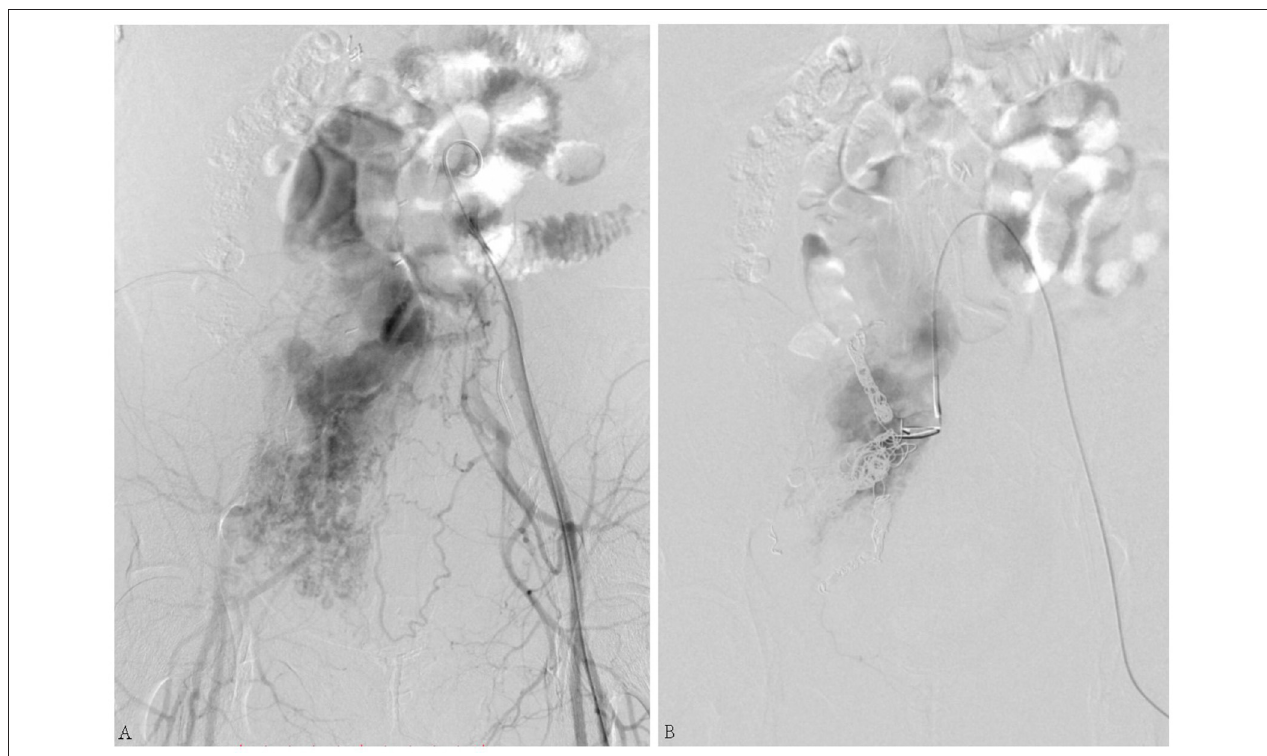
FIGURE 2 | (A) Arteriovenous fistula (AVF) connecting the right internal iliac artery and internal iliac vein. (B) Shunt flow disappeared after coil embolization.